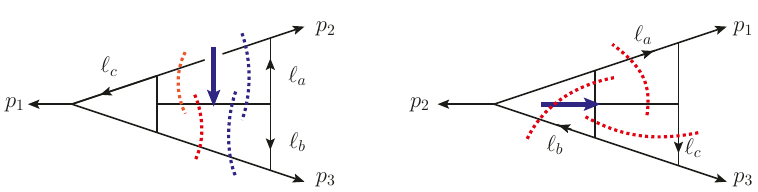
Figure 17. Irreducible-numerator candidates for two topologies. The dashed curves basically refers to rung-rule numerators. Note that the two blue lines in the left diagram refers to one (anti-symmetric) basis, and we only list half of the basis for the second